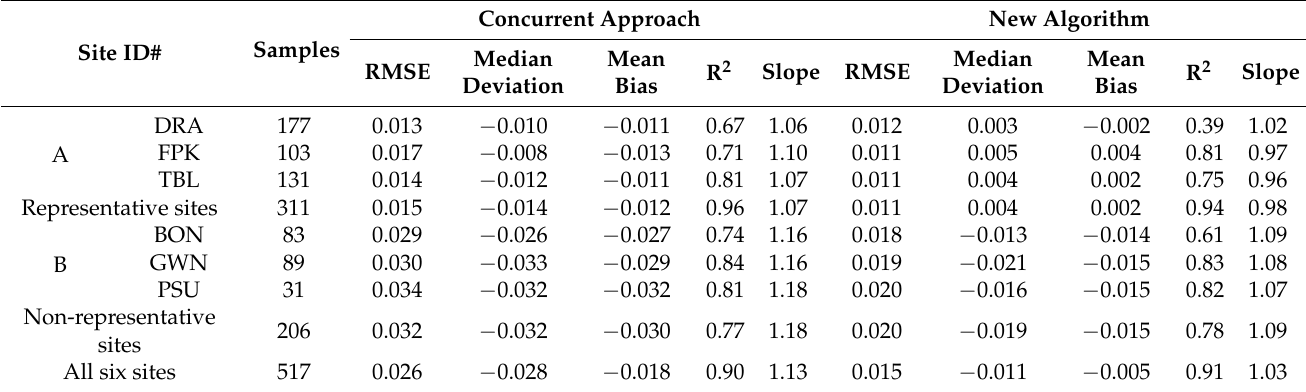
Table 5. Comparison between the Concurrent approach and New algorithm for albedo retrieval.